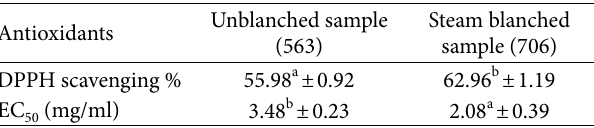
; Mean ± SD. Values in a row followed by different letters in superscript 푛 = 3 are significantly different . (푝 < 0.05)